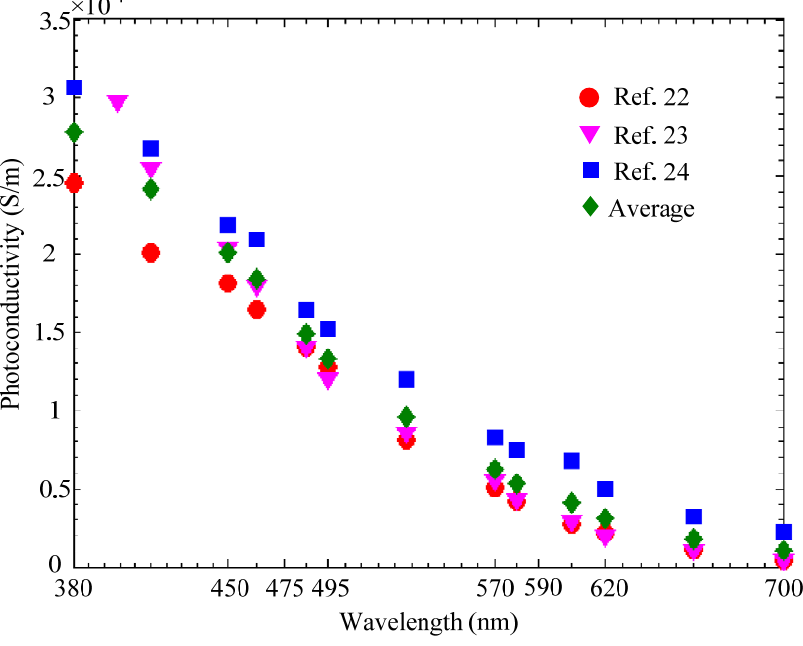
Figure 2. Absorption coefficient of a-Si:H vs . optical wavelength from several